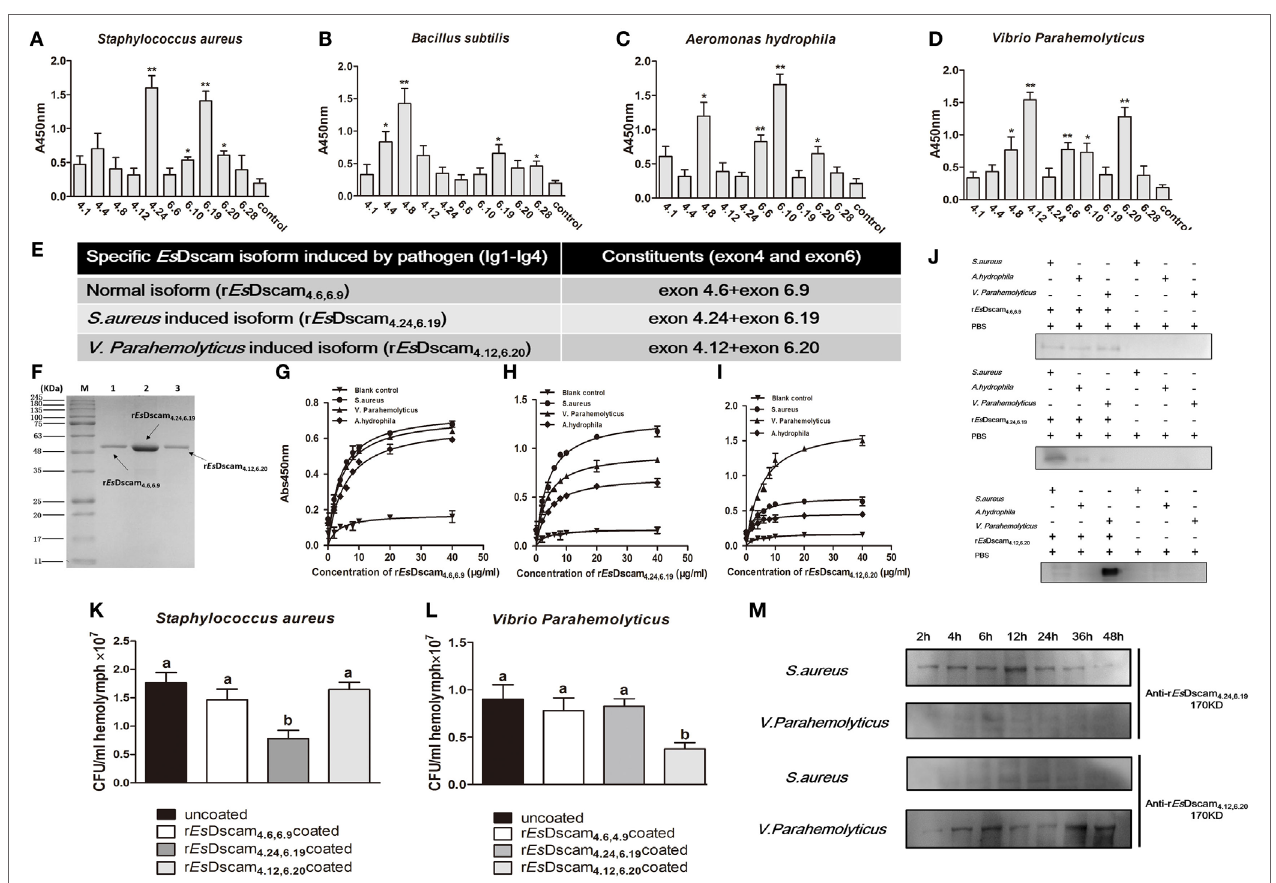
FigUre 4 | Soluble Es Dscam-specific binding with bacteria and promotes its clearance. (a–D) Bacterial binding specificity of epitope II in exon 4/exon 6. The binding activity between selected peptides and different bacteria were analyzed by ELISA with peptides that containing the conserved motif as control. Three independent repeats were performed, and results are expressed as the mean ± SD. Data were analyzed by Student’s t -test. * p < 0.05, ** p < 0.01. (e) Specific recombinant Es Dscam isoforms induced by pathogens. Normal isoform composed of alternative spliced exon 4.6, alternative spliced exon 6.9, and constant exon designated r Es Dscam 4.6,6.9 ; Staphylococcus aureus -induced isoform composed of alternative spliced exon 4.24, alternative spliced exon 6.19, and constant exons designated r Es Dscam 4.24,6.19 ; Vibrio parahemolyticus -induced isoform composed of alternative spliced exon 4.12, alternative spliced exon 6.20, and